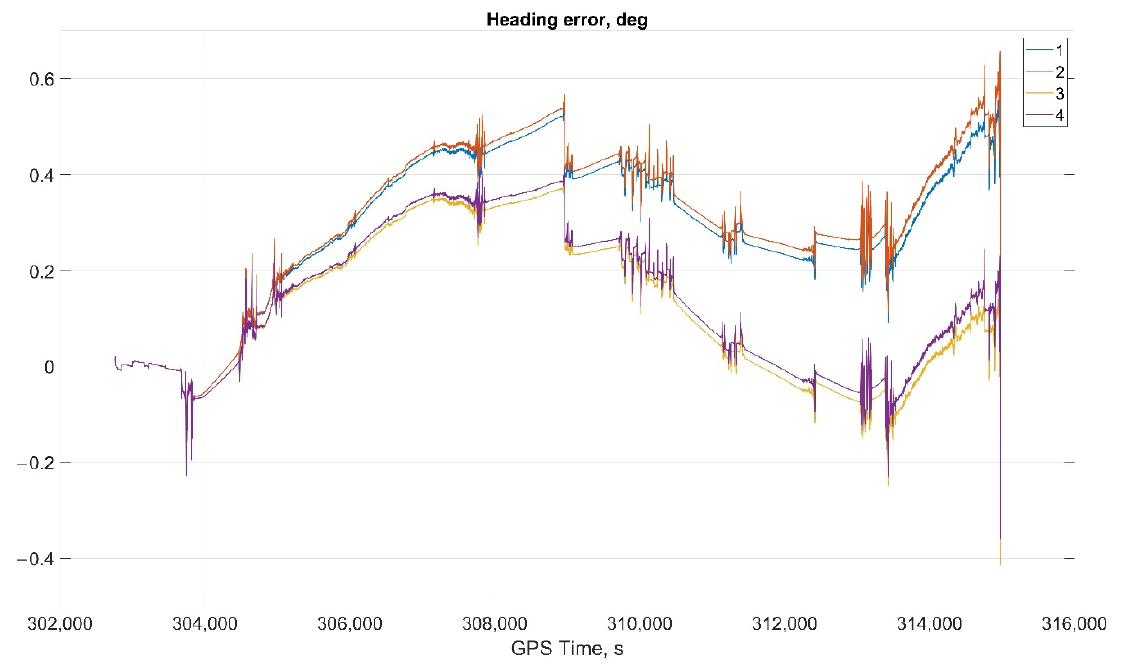
Figure 10. Heading error in car test (1, Transformation matrix approach; 2, Direct angles calculation approach; 3, Transformation matrix approach using GNSS data; and 4, Direct angles calculation approach using GNSS data.